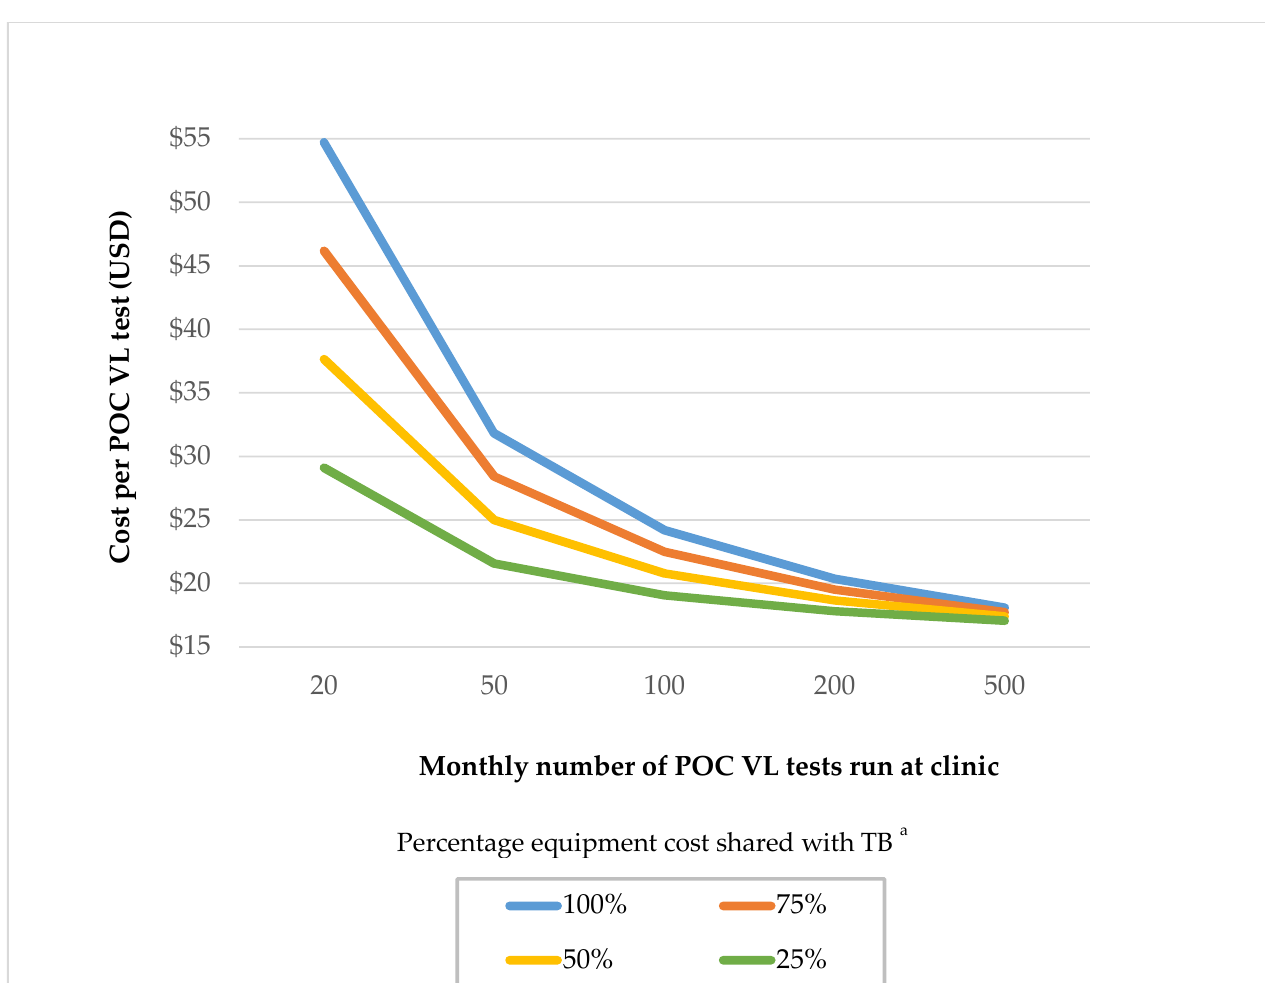
Figure 1. a Sensitivity analysis assessing the potential impact of cost-sharing of POC GeneXpert instruments with TB diagnostics. As POC VL is not yet rolled out, the potential for cost-sharing equipment with other diseases remains uncertain. Therefore, we present costs assuming 25%, 50%, 75%, and 100% of the equipment is used for POC VL testing, with the remaining absorbed by other diagnostics programs like TB.